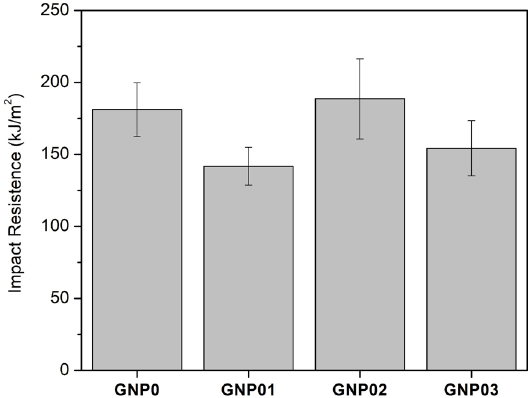
Figure 2. Impact strength of the samples